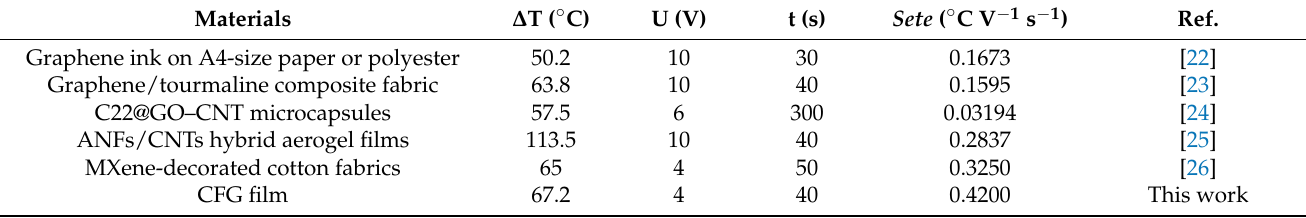
Table 2. Comparison of the Sete of some recent electro-thermal materials and the CFG film. Materials